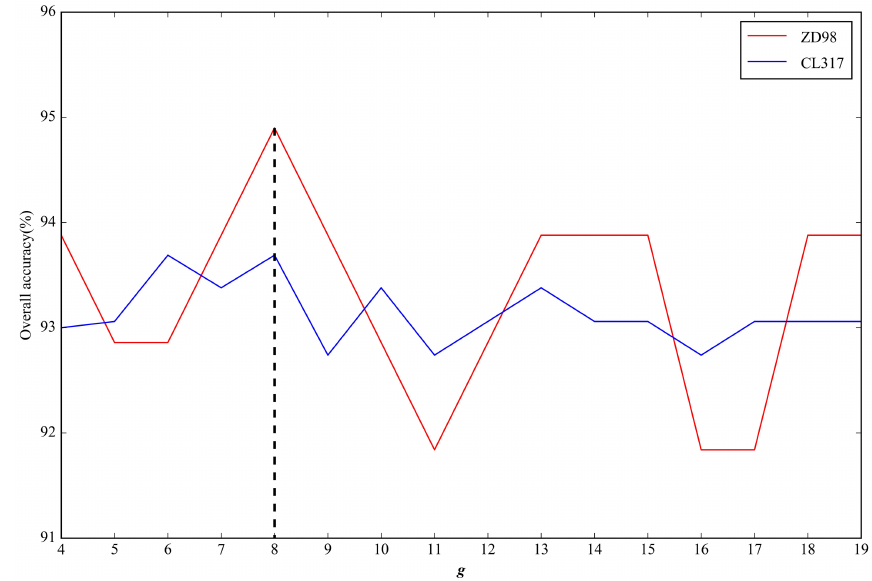
Figure 3. The effect of g on overall accuracy based on the datasets ZD98 and CL317 after ACC transformation of the